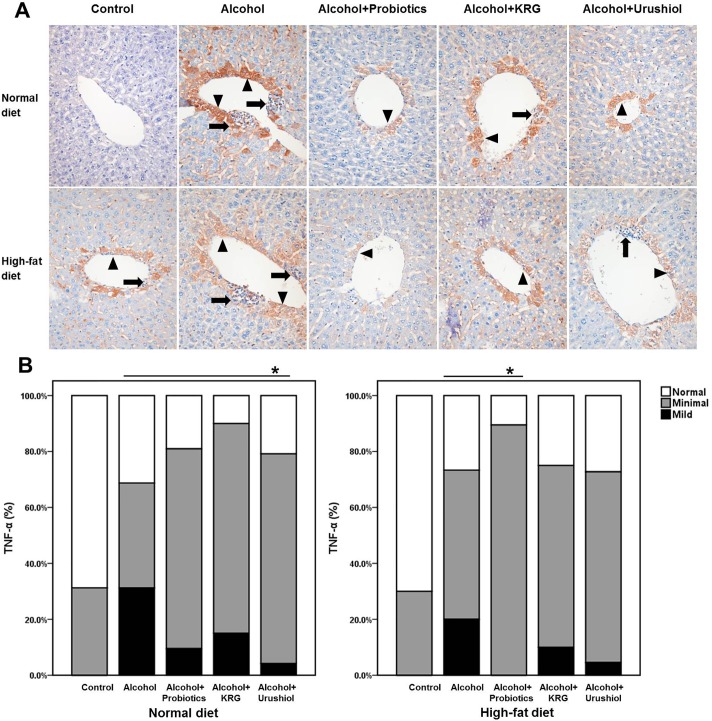
Immunohistochemical findings (A; TNF-α) and grade of TNF-α (B).TNF-α for immunohistochemical stain shows the cytoplasmic positivity (black arrowhead) in the perivenular hepatocytes around the inflammatory cells (black arrow). The intensity of the stains in the probiotics, KRG, and urushiol groups is mildly decreased than that of the alcohol only group. KRG, Korea red ginseng; TNF-α, tumor necrosis factor-α. * p < 0.05.